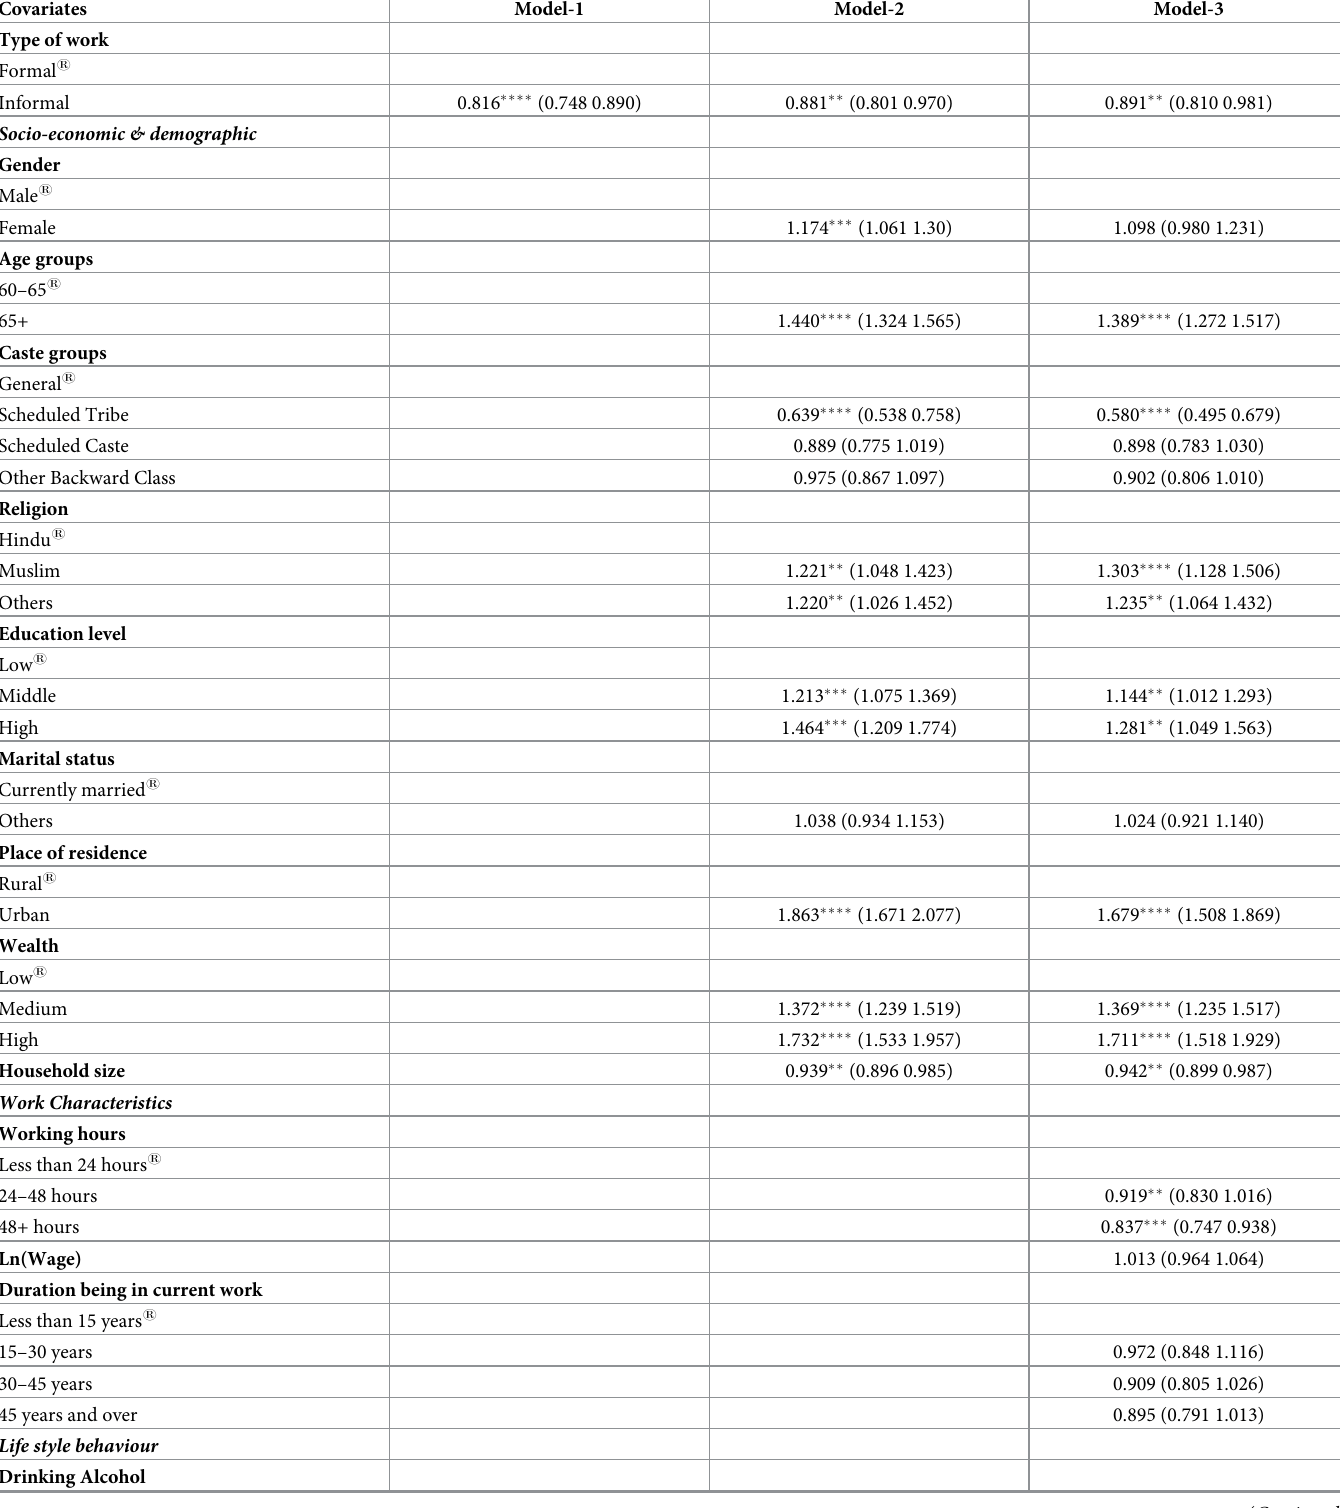
Table 4. Odds of multiple logistic regression for